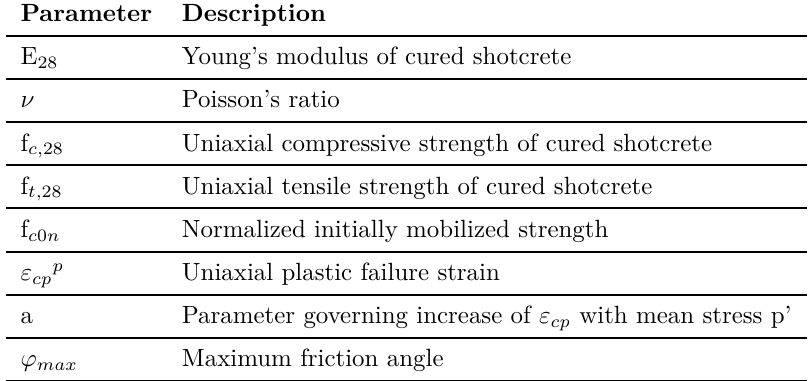
Table 3. Input parameters related to strain